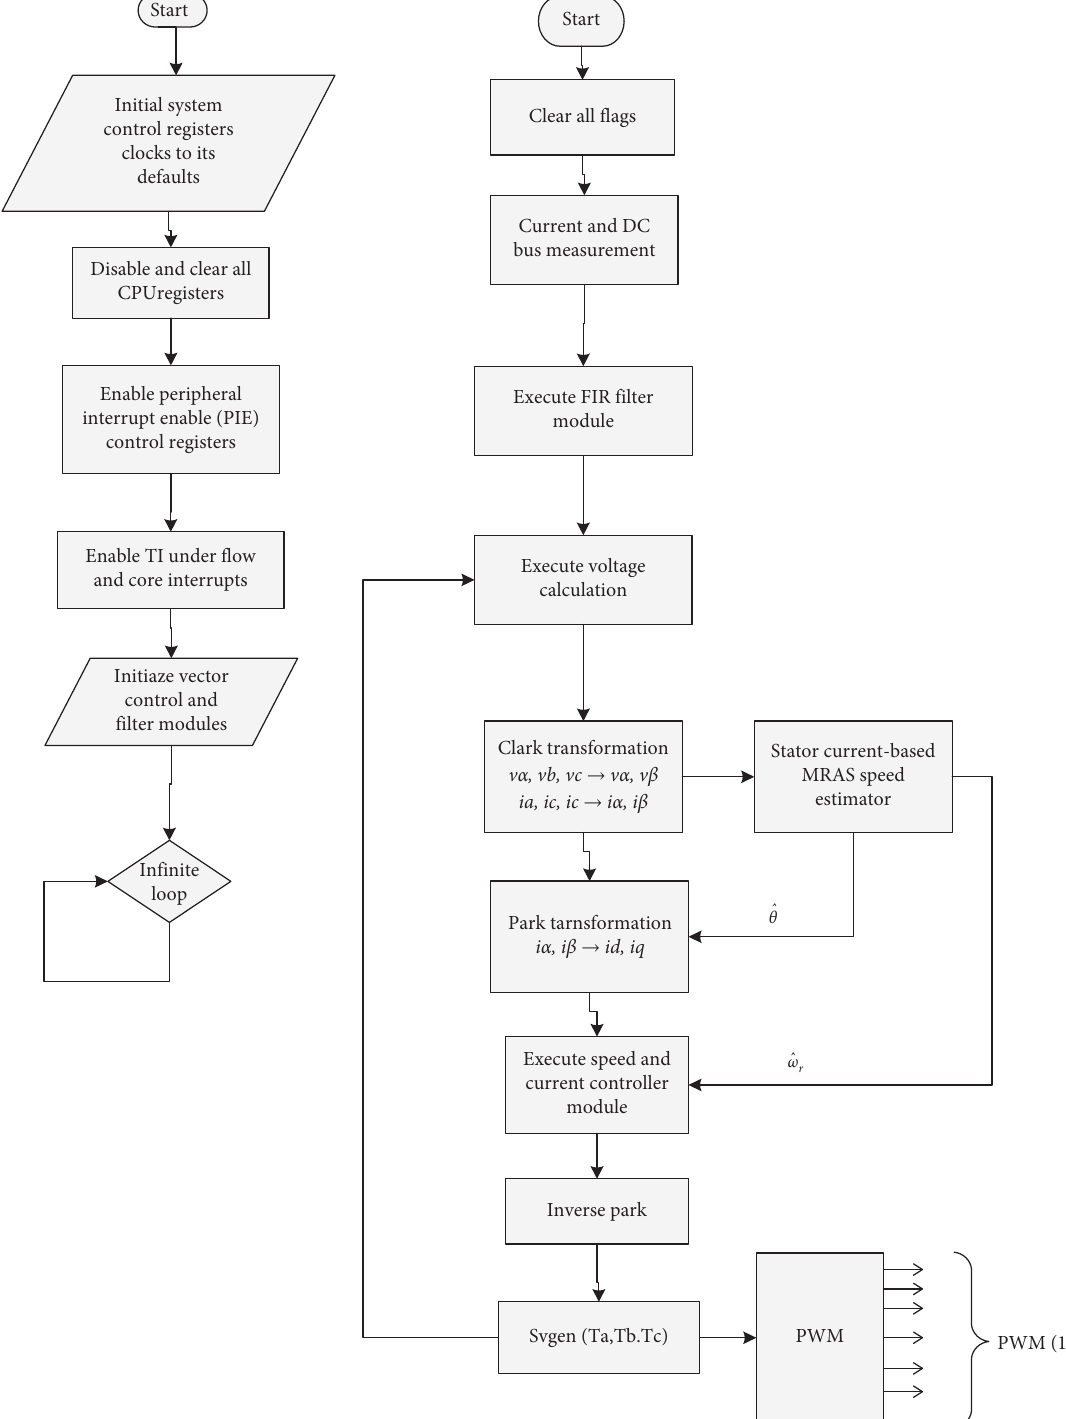
Figure 23: Flowchart of the proposed